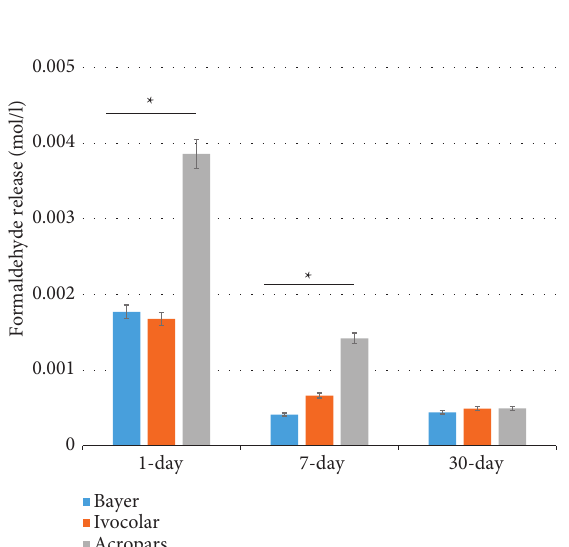
Figure 1: The amount of formaldehyde release (mol/L) is cate- gorized by the type of acrylic resin according to follow-up intervals.